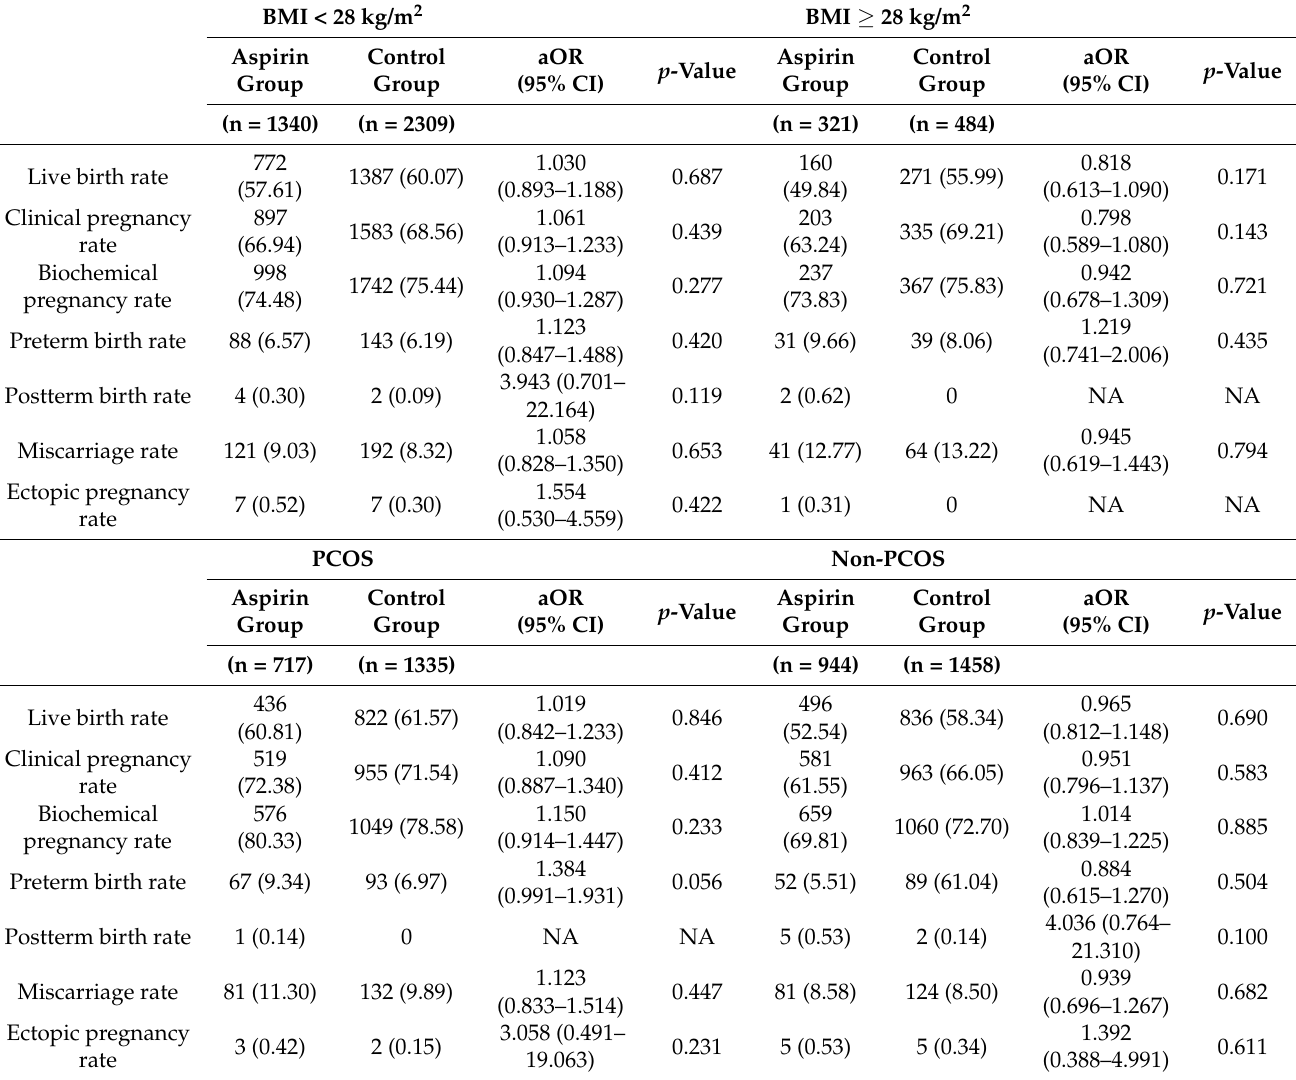
Table 4. Relationships between aspirin and pregnancy outcomes in different subgroups.